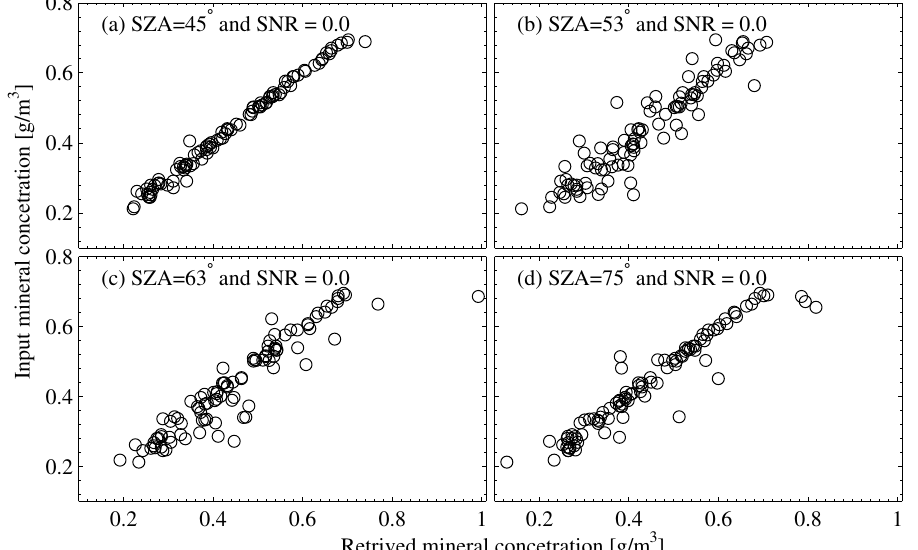
Figure 5. Comparison between input values and retrieved values for the mineral concentration for different solar zenith angles